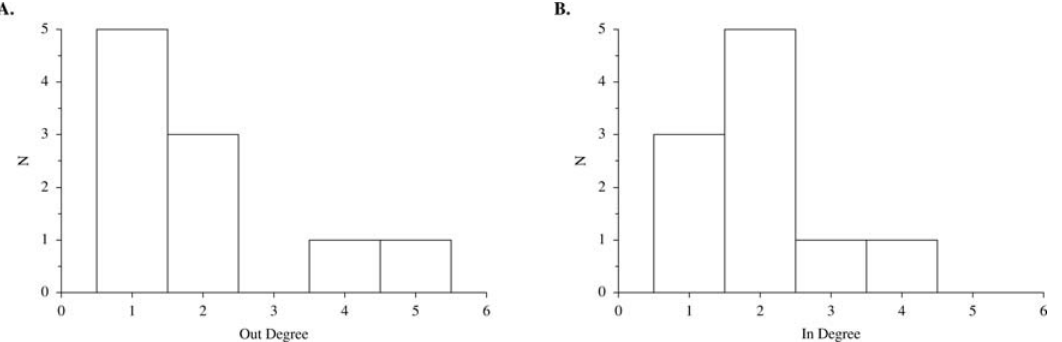
Figure 10. In- and out-degree distributions of evolved networks. Shown are (A) in-degree and (B) out-degree distributions for the evolved network in Fig. 9A, the result of selection on attractor size, and (C) in-degree and (D) out-degree distributions for the network in Fig. 9B, the result of selection on attractor number. These distributions may be compared to the random expectations for N =10 in Fig. 3.